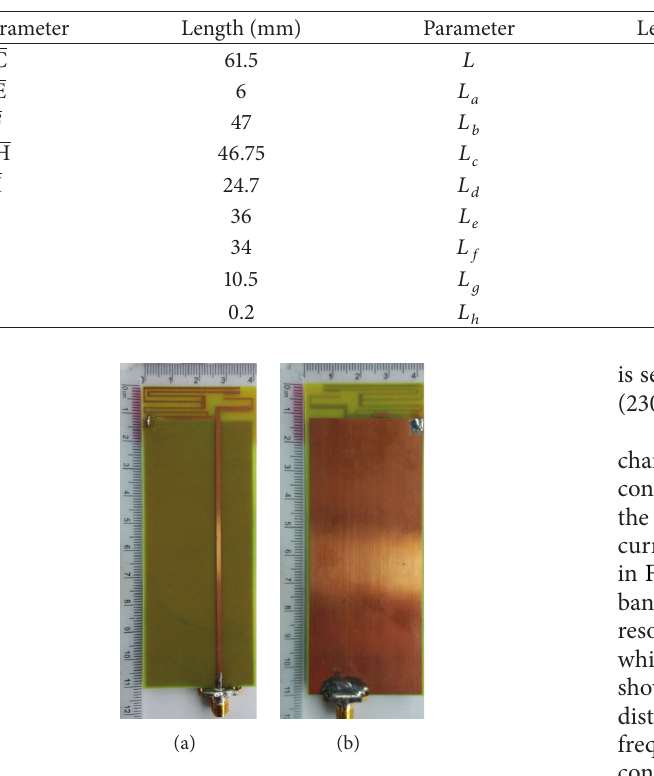
Figure 2: Experimental prototype of the proposed compact printed antenna (a) top view and (b) bottom